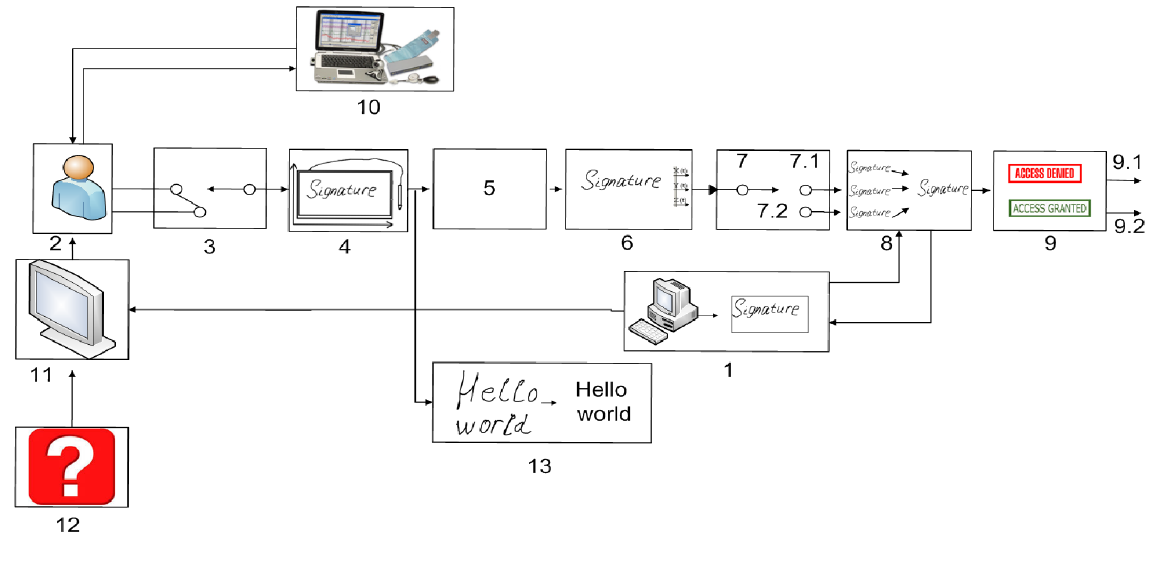
Figure 5. The structural diagram of person identification: 1 —a signature generator; 2